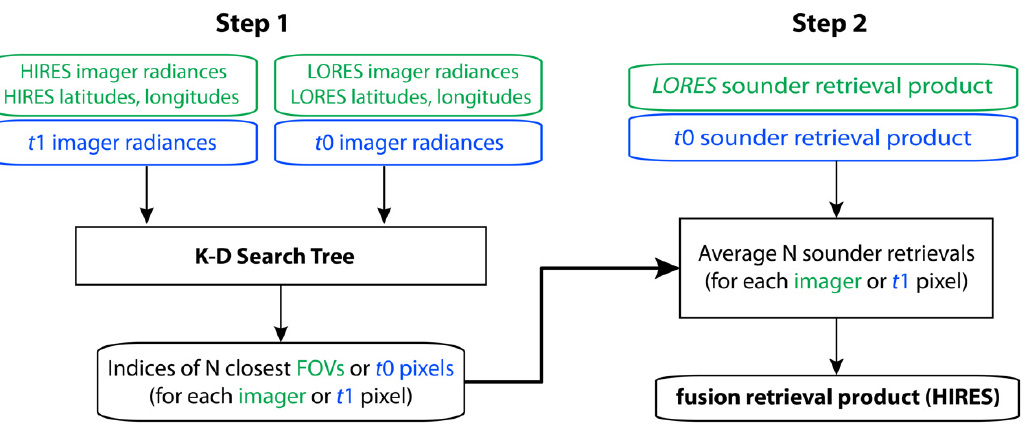
Figure 1. Schematic of the LEO sounder plus GEO imager spatial (in green) and temporal (blue) fusion approach. The fusion process starts at the sounder overpass time t 0, and the first temporal fusion occurs between t 0 and an adjacent timestep t 1; temporal fusion is then repeated for the next neighboring times. LORES and HIRES refer to low spatial and high spatial resolution, respectively.